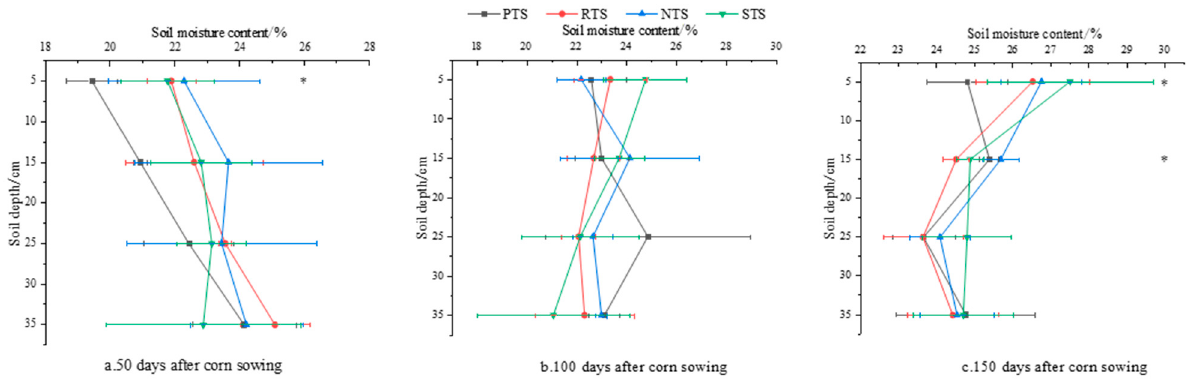
Figure 2. Effect of tillage and sowing methods on soil moisture content. Note: * Indicates a significant difference at 0.05 level. PTS—plow tillage and sowing; RTS—rotary tillage and sowing; NTS—no-tillage and sowing; STS—no-tillage and precise sowing in stubble field. The same below.